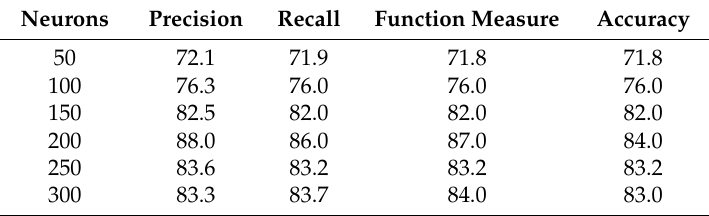
Table 3. Classification accuracy of Bi-LSTM with different number of